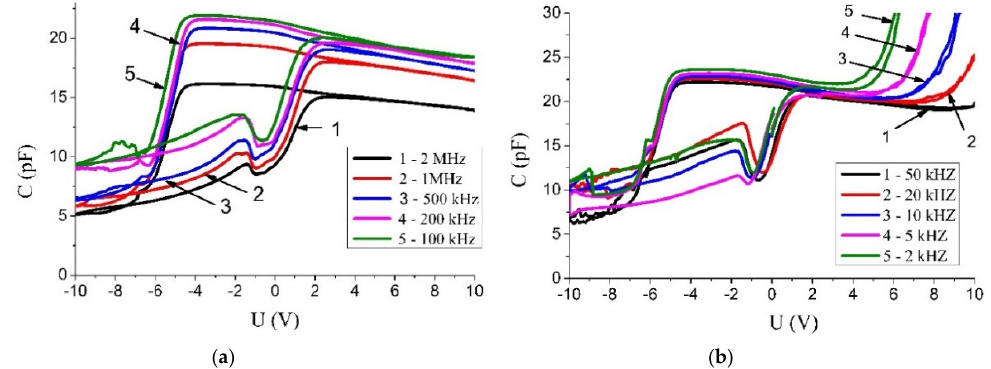
Figure 7. Capacitance-voltage characteristics of the Si/SrTiO 3 /Ni heterostructure recorded in the frequency ranges of 100 kHz-2 MHz ( a ) and 2 kHz-50 kHz ( b ).